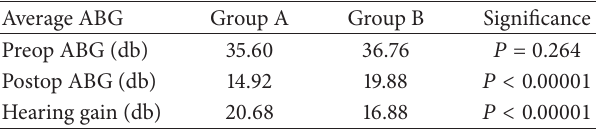
Table 1: Hearing evaluation in both groups (ABG: air bone